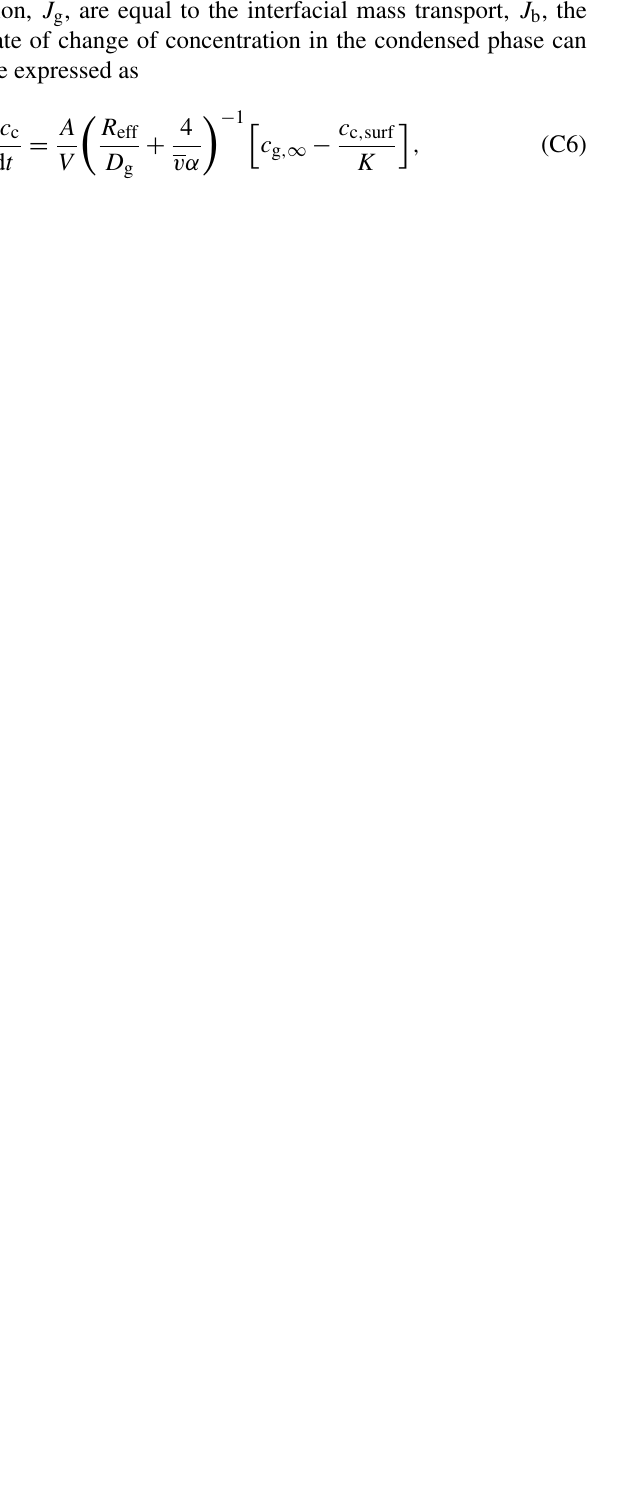
(cid:16) (cid:17) − 1 R eff + 4 where the term “ A ” is often referred to as the V D g vα mass transfer coefficient, k mt , for a chemical species trans- fer from air to liquid or solid. The mass transfer coefficient for the chemical into a spherical droplet with radius R eff is described as DI then the concentration at the grain